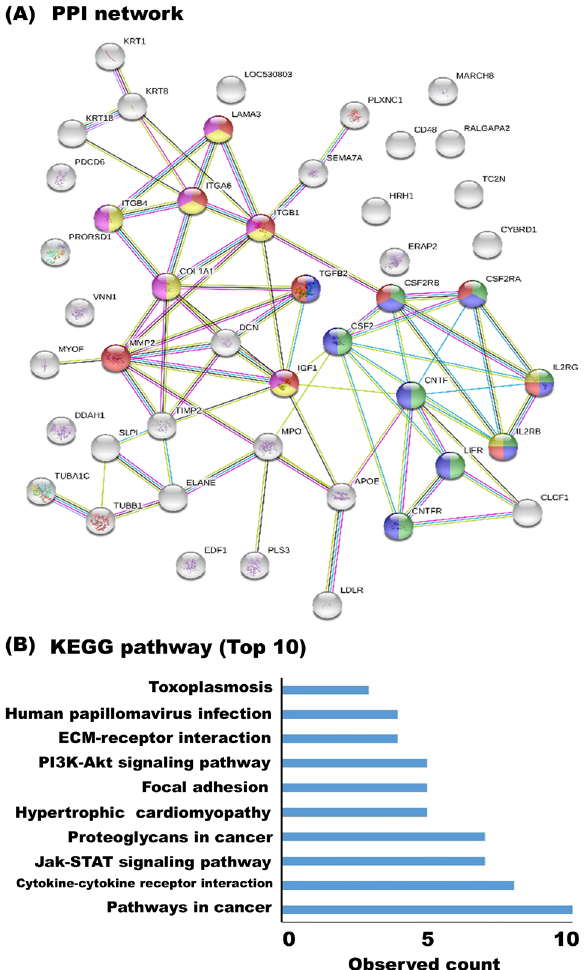
In the network, nodes and edges indicated milk sEV proteins and physical and/or functional interactions of the milk sEV proteins, respectively. Empty nodes represent the proteins of unknown three-dimensional structure, and filled nodes represent the proteins with some known or predicted three-dimensional structure. Different coloured lines between the proteins represent the various types of interactions in STRING (databases, experiments, neighbourhood, gene fusion, co-occurrence, text mining, co-expression, and homology). The candidates for differentially expressed proteins in milk sEV from BLV-infected cattle were analysed using KEGG software, and the top 10 KEGG pathways were demonstrated in the bar diagram ( B